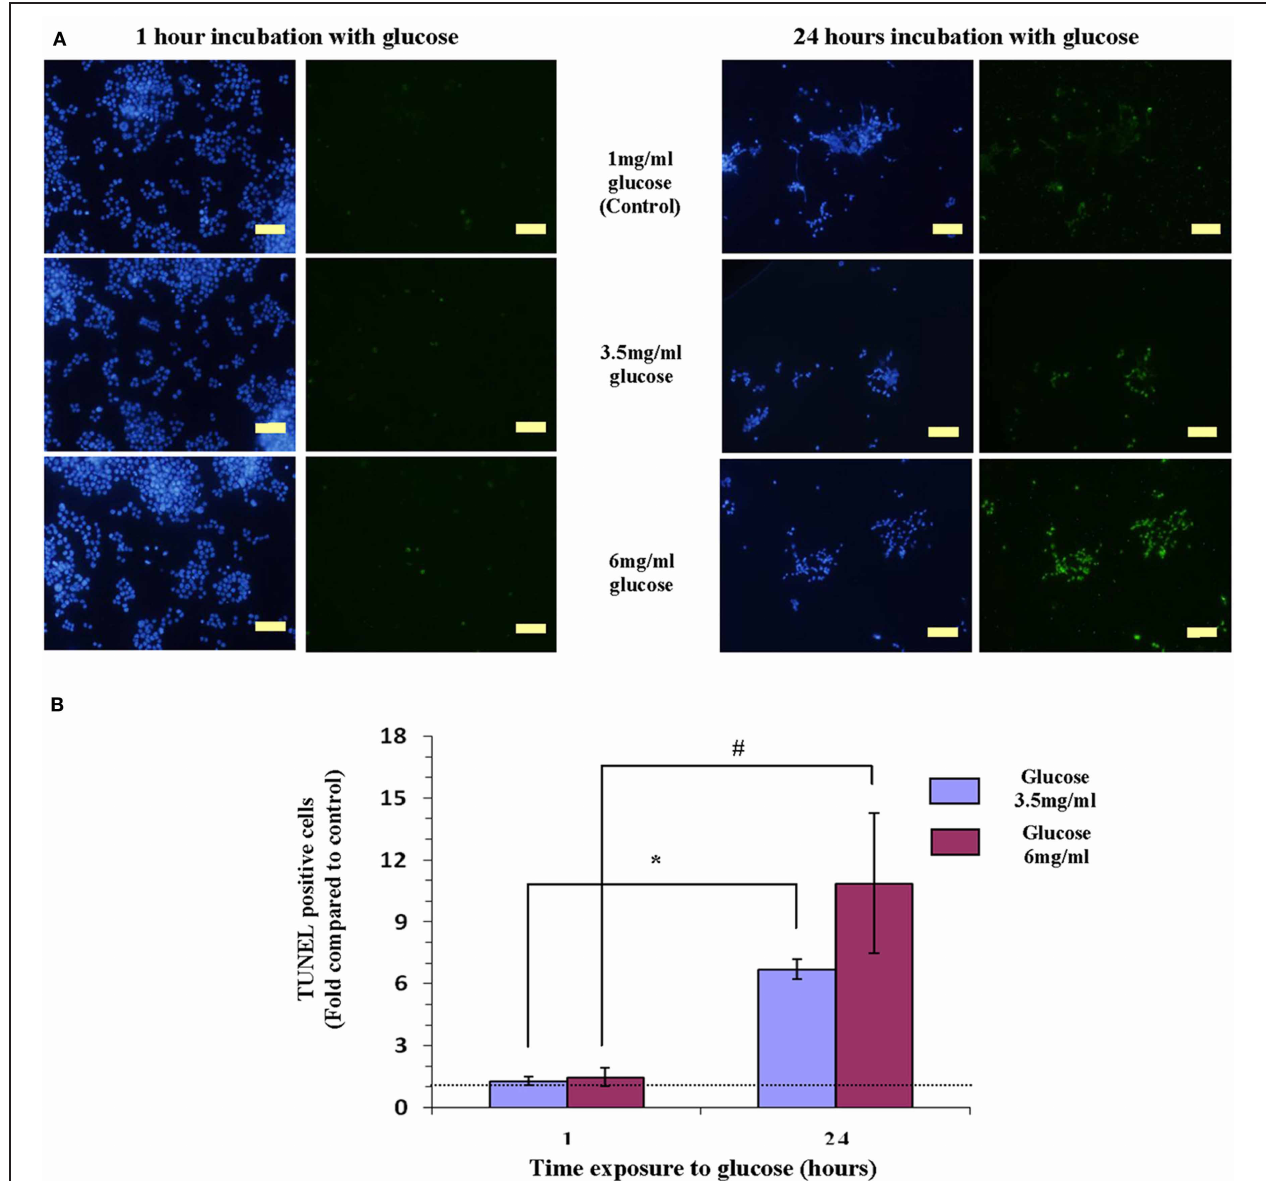
FIGURE 1 | Hyperglicemia (3.5mg/ml or 6mg/ml of glucose)-induced apoptosis induction in Y79 cells. (A) Cells tested by TUNEL to detect apoptosis (green) and stained with DAPI for detecting nuclei (blue). Y79 cells were pre-treated for 16–24h in starvation medium (1% FBS and 1mg/ml glucose), and then incubated for 1h with 3.5mg/ml glucose did not show